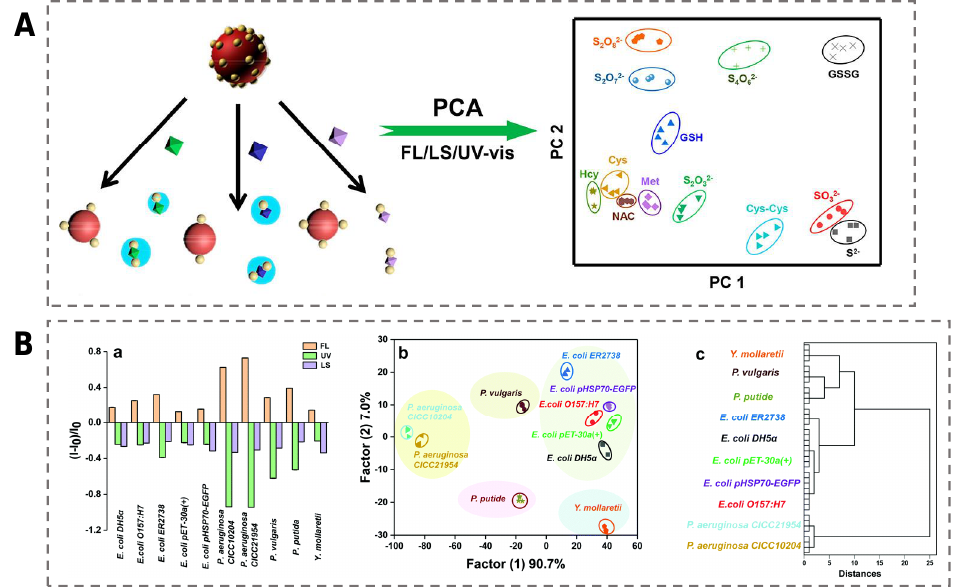
Figure 6. Unsupervised-algorithm-based colorimetric sensor array for pathogen identification. ( A ) A colorimetric sensor array based on the (+)AuNPs/FA-AuAgNCs composite for discrimination of sulfur-containing species and bacteria with PCA algorithm. Reproduced with permission [110]. Copyright 2019, American Chemical Society. ( B ) A colorimetric sensor array based on the (+)AuNPs/AuNCs complex for Gram-negative bacteria identification with HCA algorithm. ( a ) The triple optical response pattern of nanocomplex after incubtion with Gram-negative bacteria. ( b ) LDA for the discrimination of ten different Gram-negative bacteria. ( c ) Dendrogram of HCA for ten different Gram-negative bacteria. Reproduced with permission [111]. Copyright 2022, Royal Society of Chemistry.